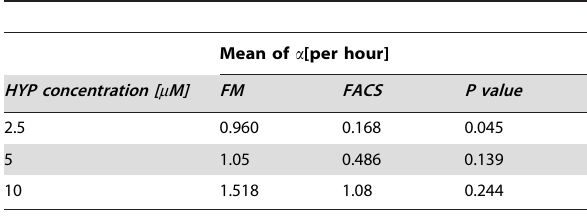
h i a : u : at different h